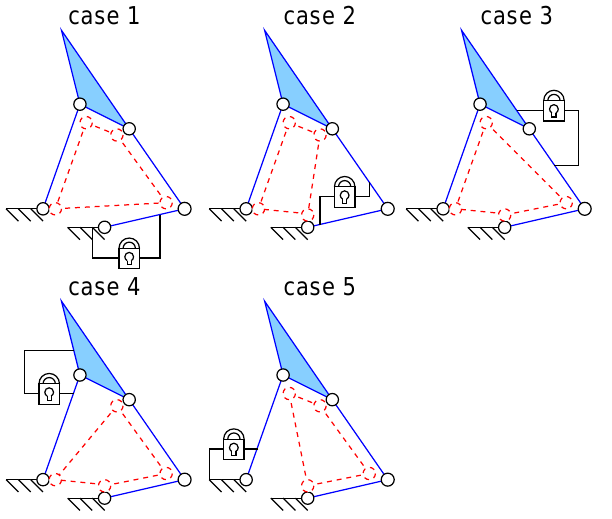
Figure 3. Kinematic reductions of the two-phalanx class S finger with one triggered element.